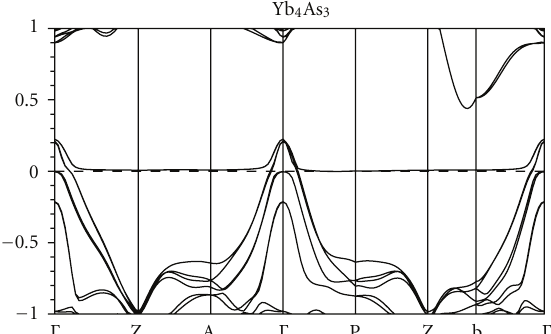
= 5 . 3eV, U (3+) = e ff e ff Figure 78: Self-consistent LSDA+ U energy band structure of Yb 4 As 3 along the high-symmetry directions and for energies close to the Fermi level [423], (here, U (3+) Yb 2+ ions is treated as a core